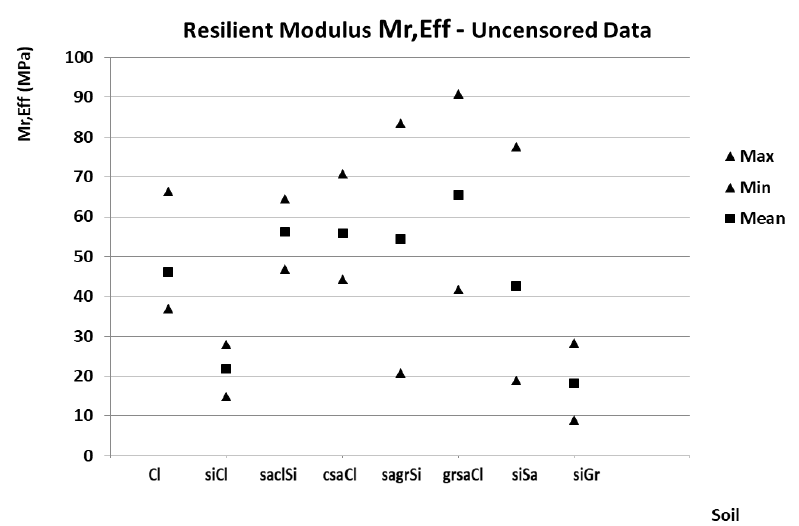
Figure 11. Resilient modulus M r,eff for soil siGr.